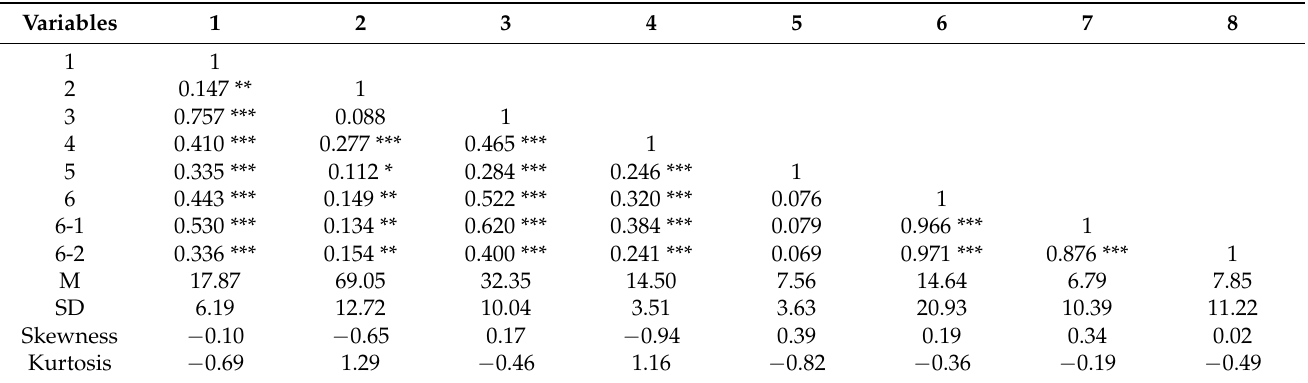
Table 2. Correlational matrix of preoccupation with devotional songs, the emotionally